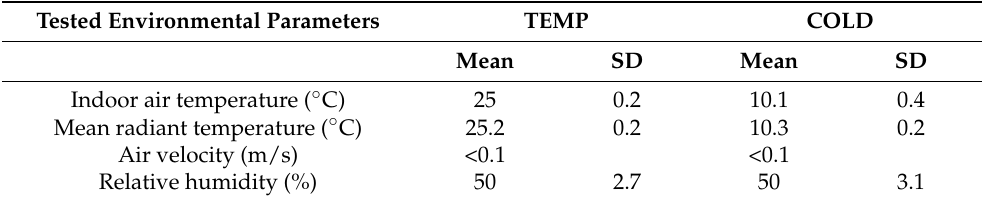
Table 1. The environmental parameters tested in the